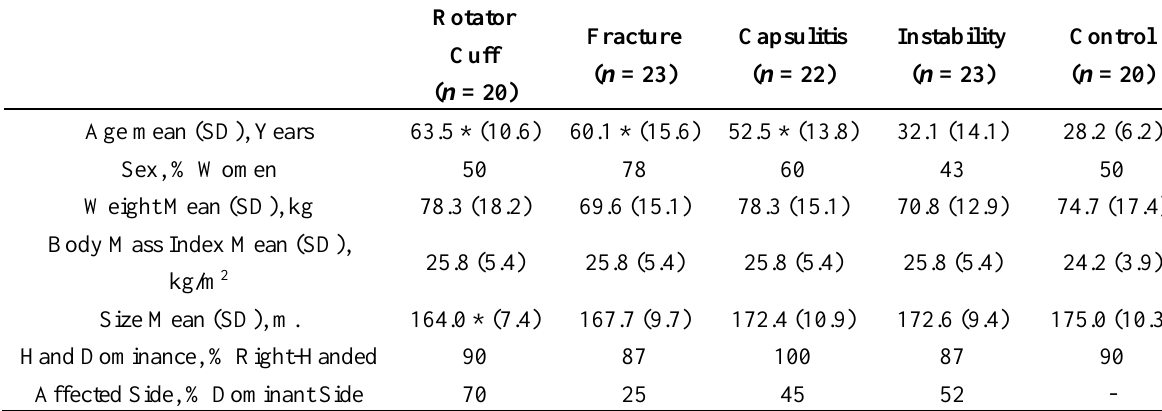
Table 1. Participants’ characteristics by